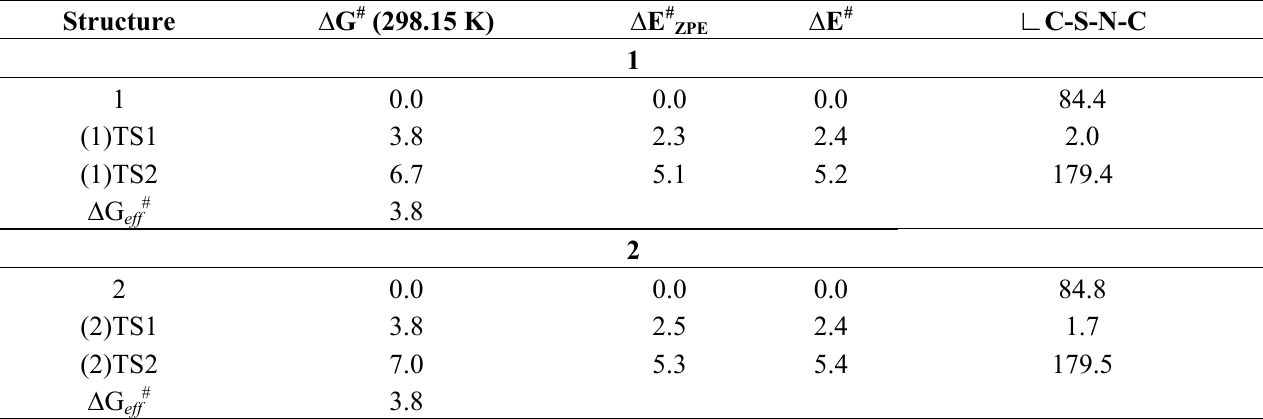
Table 5. Relative energies (kcal·mol − 1 ) and dihedral angles (°) of transition and ground states a .